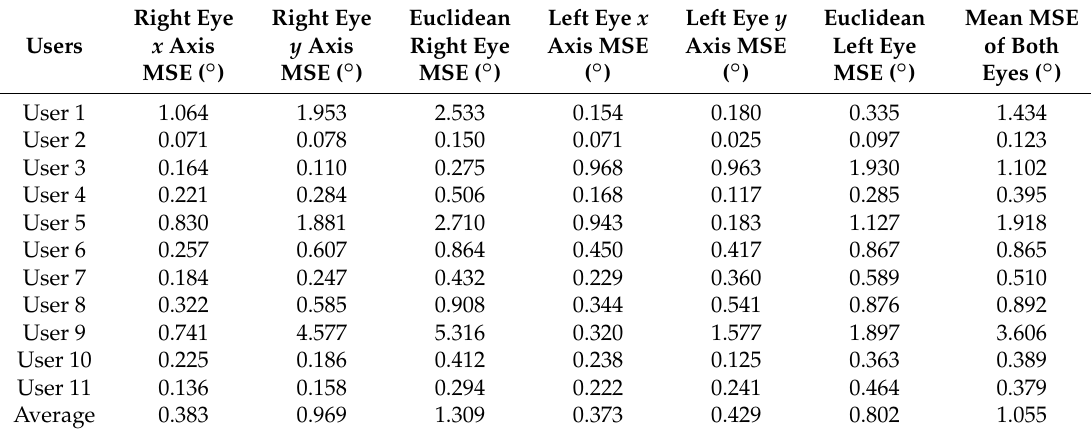
Table 4. Estimation results of gaze tracking mean square errors in degrees.